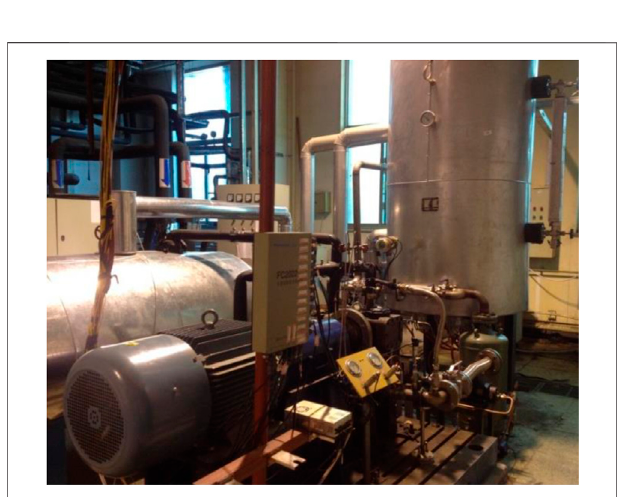
FIGURE 2 | The experiment table of Organic Rankine Cycle system.